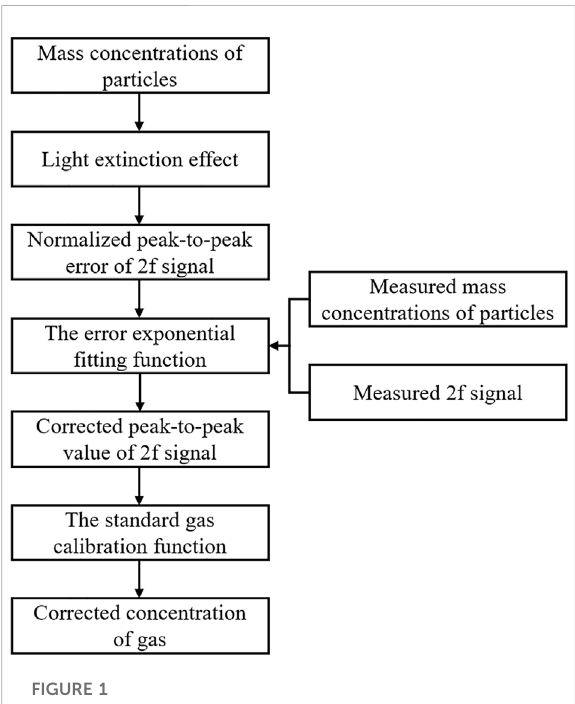
FIGURE 1 Correction fl ow chart of the peak-to-peak value of 2f signal and gas